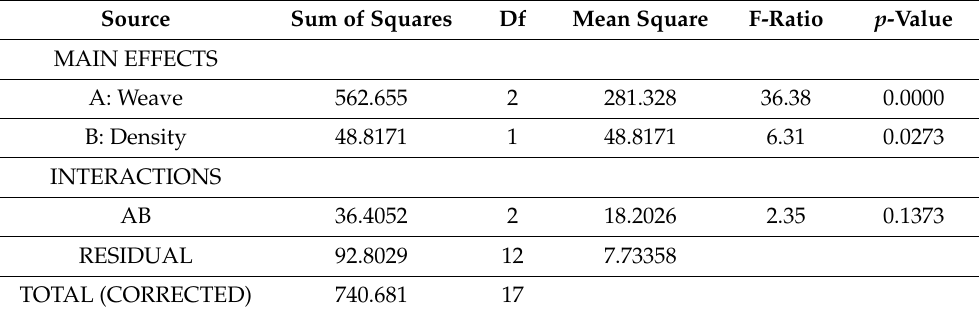
Table 7. Impact of weave and density on the adhesion force for simple fabrics for z2.